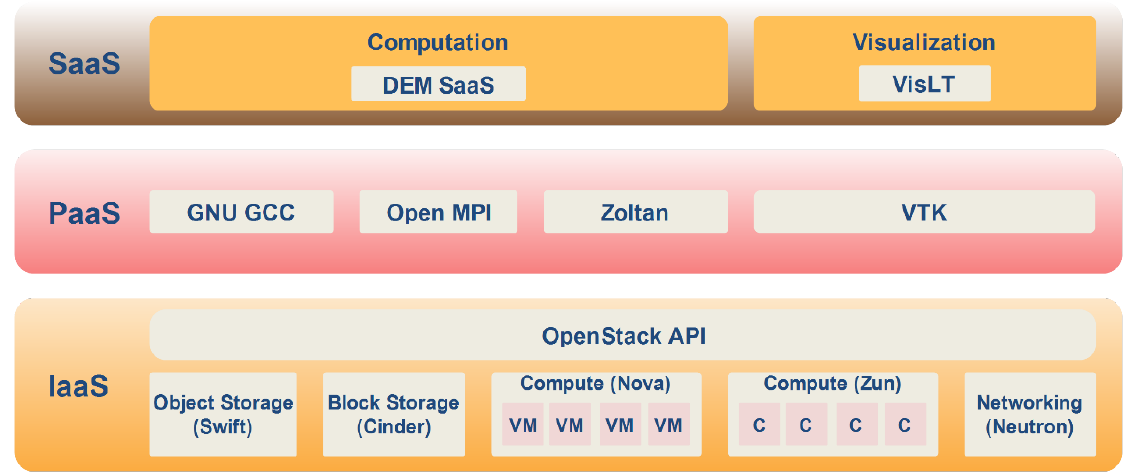
Figure 1. Layers of cloud services.